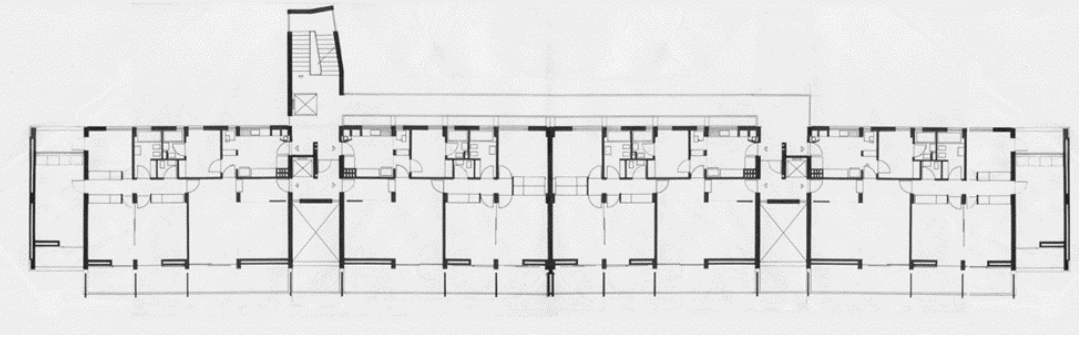
Figure 1. Plan of the entrances: intermediate floor over the basement.